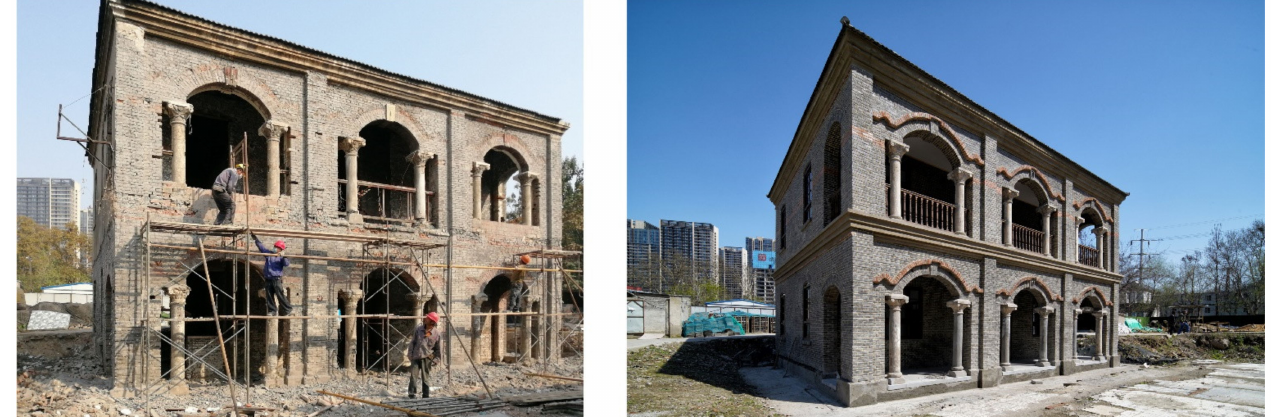
Figure 26. No. 8 Building of “Tianxiangli” (Priest’s Residence) before conservation ( left ) and after conservation ( right ). Along the Yangtze River is the window for opening ports in modern China, and the “Tianzihao” colony is one of the most important landmarks in the Nanjing section of the Yangtze River. The “Tianzihao” colony is of French-style buildings in combination with ancient Chinese architectural techniques. At present, it is an important architectural case in Nanjing, Jiangsu Province and even all over the country, reflecting the modern architectural style influenced by cultural exchanges between China and the Western world. Its architectural technical features have been protected, and Western architectural styles have been highlighted through relevant research and conservation. This is the carrier and evidence of the cultural exchange and integration between China and the Western world in more than 100 years of modern